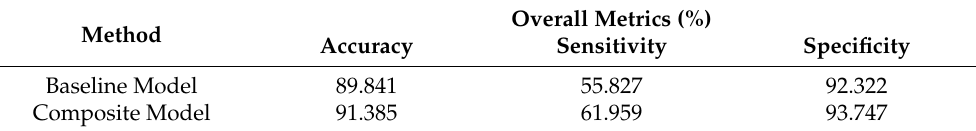
Table 8. Overall performance metrics for baseline model and composite